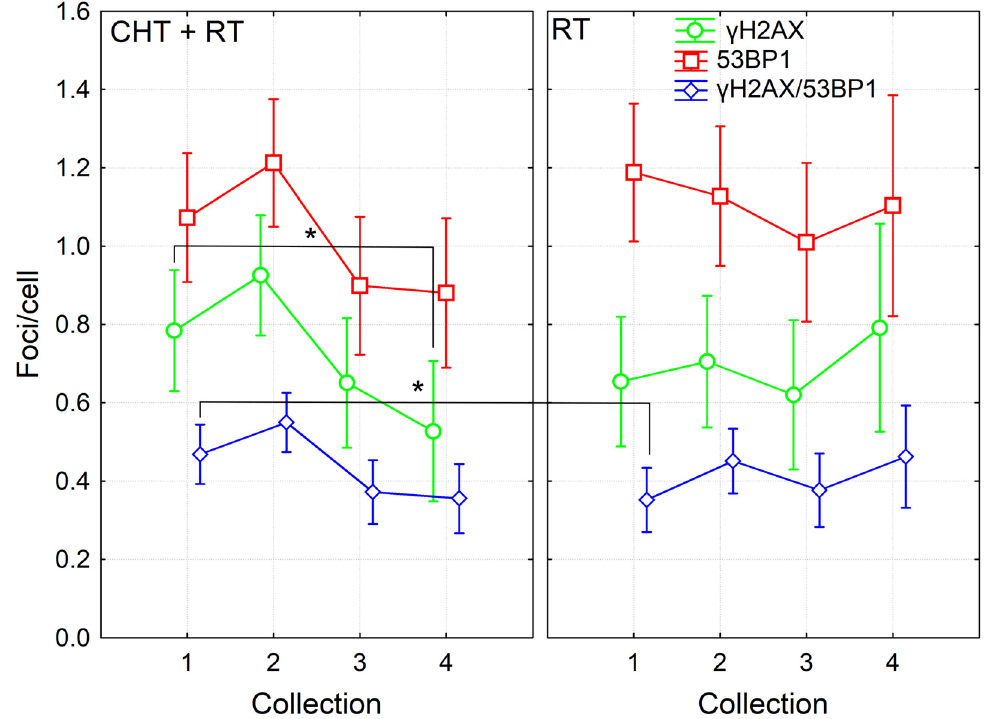
Figure 2. DNA repair γ H2AX /53BP1 foci in PBL from BC patients collected before (1), 24 h after 4th fraction (2) and after RT (one month (3), one year (4)) from patients treated with either RT (twenty-six patients) or CHT+RT (thirty-one patients). Data are shown as mean with 95% confidence interval. p -values are indicated by asterisk (* p ≤ 0.05).